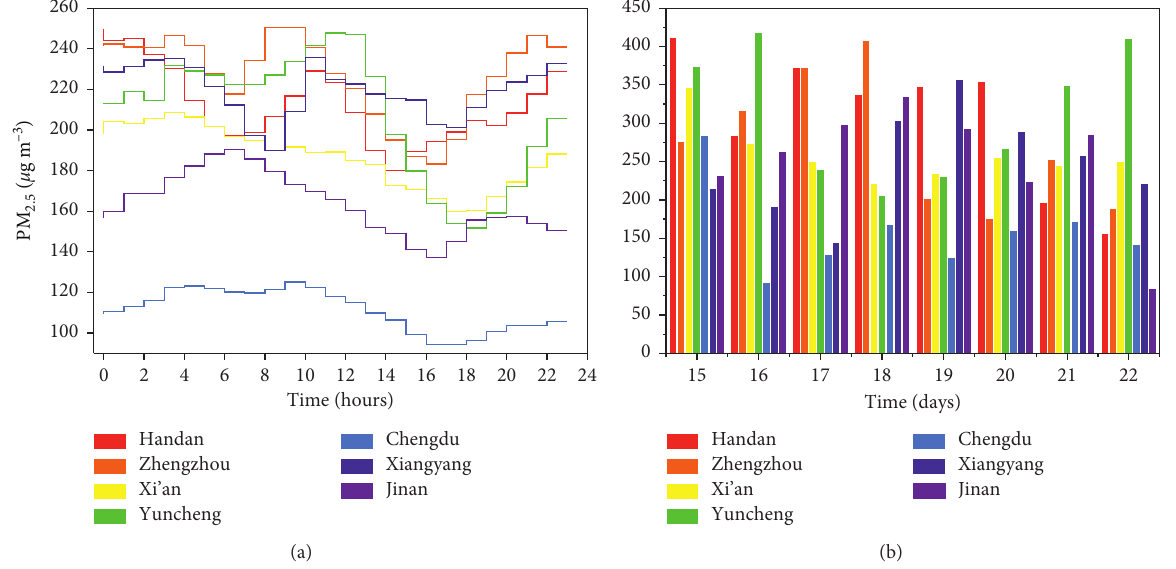
Figure 3: Hourly (a) and daily (b) mean PM 2.5 concentrations in seven Chinese cities during the pollution period. Table 3: Pearson correlation coefficients between PM 2.5 , PM 10 , CO, NO 2 , O 3 , and SO 2 in seven Chinese cities. Handan